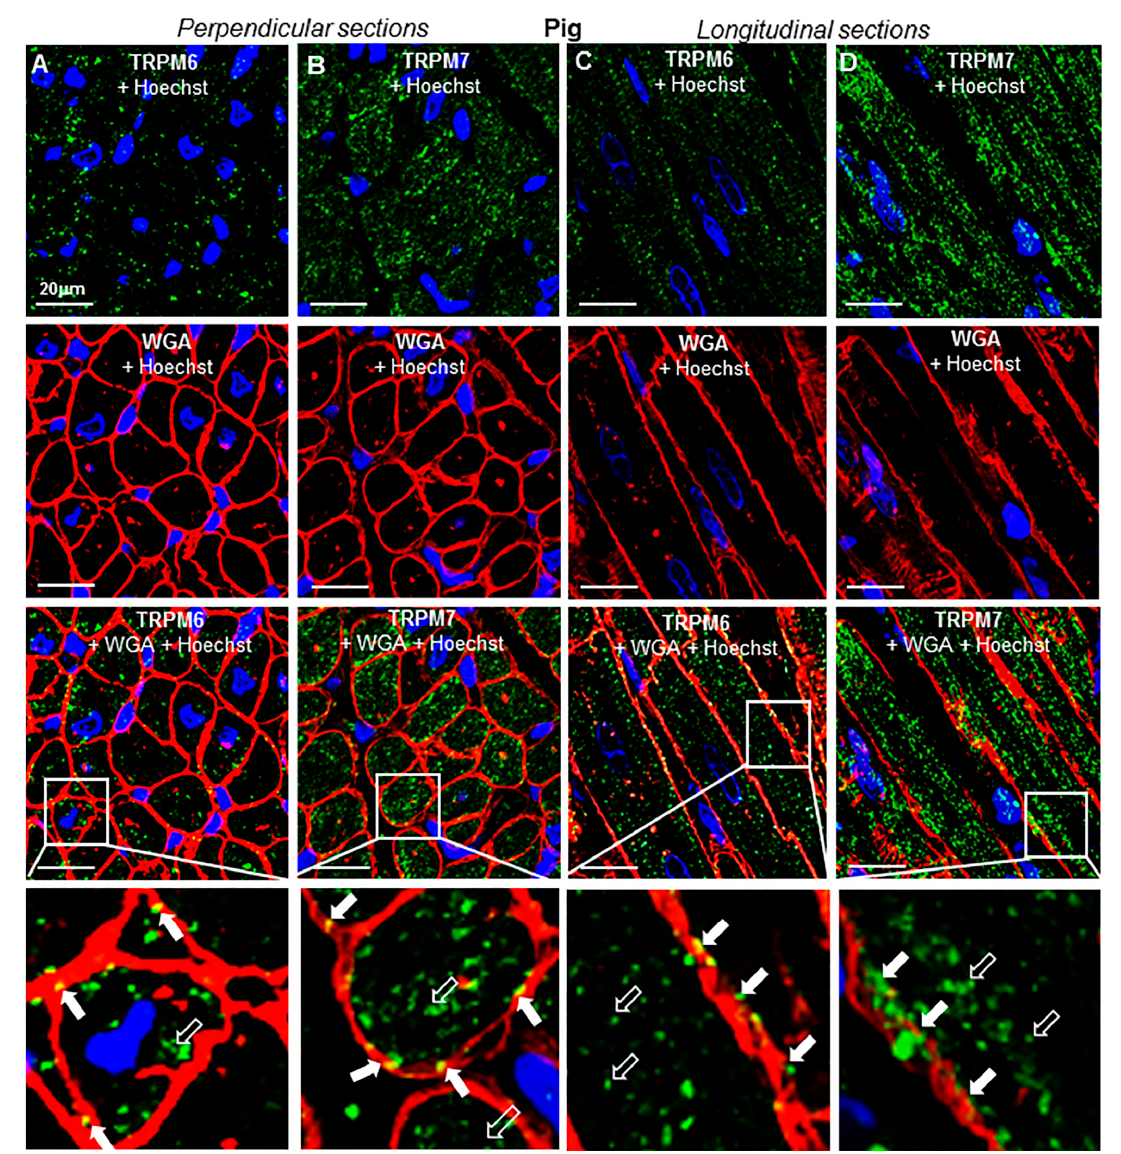
Figure 5. Tissue-level and subcellular localization of TRPM6 and TRPM7 by immunohistochemistry in the pig RA: ( A – D ) Confocal microscopy images obtained from perpendicular ( A , B ) and longitudinal ( C , D ) tissue slices. Images shown at higher magnification in the lower panels correspond to zoomed-in areas delimited by squares at a lower scale in the upper panels. TRPM6 and TRPM7 proteins were detected with AF-488-conjugated antibodies (green), the cell surface was labeled with AF-555 for wheat germ agglutinin (WGA, in red), whereas the nucleus staining (with Hoechst 33342) appears in blue. Notice that TRPM6 and TRPM7 are detected both at the cell membrane (filled arrows) and intracellularly (unfilled arrows). Scale bars indicate 20 µm.